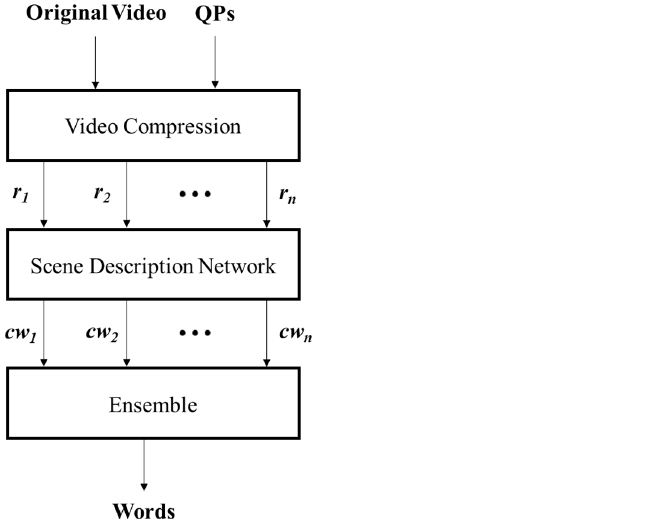
Figure 5. Consideration of the n reconstructed videos of various quality in the scene description.